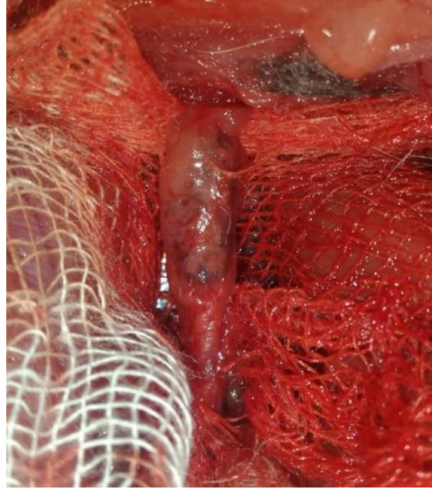
Figure 4. Explantation of the iliac artery with implanted stent. Image obtained using OPMI Pico microscope (Carl Zeiss, Oberkochen,